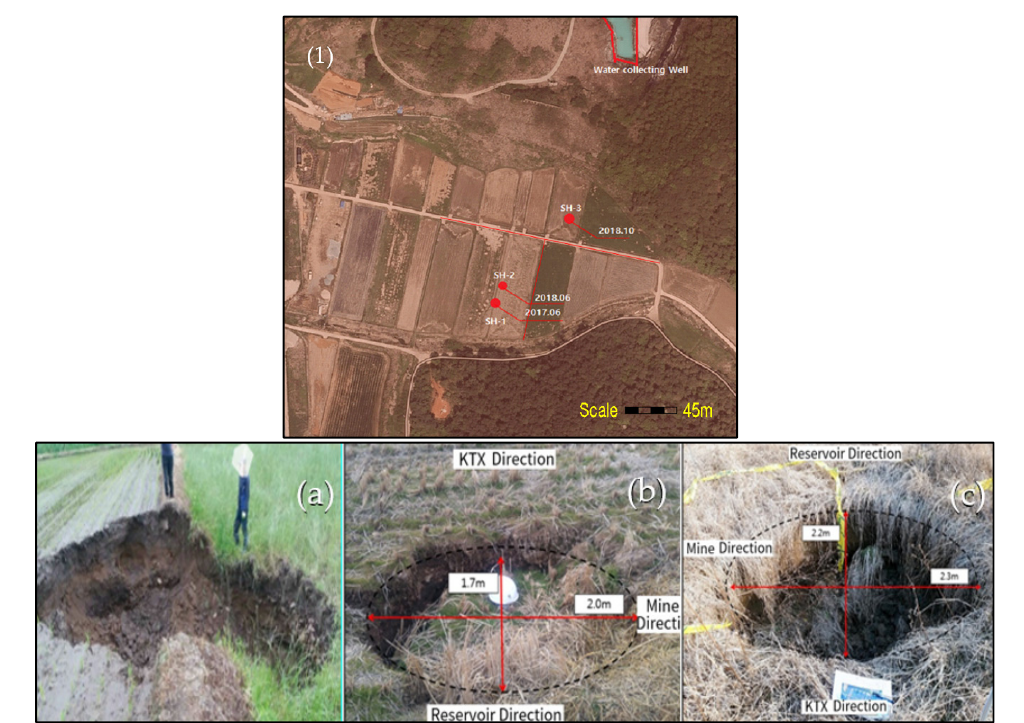
Figure 6. Sinkhole locations and close-up photographs of sinkholes in agricultural land adjacent to Gun-dong mine, (1) Sinkhole locations, ( a ) 2017.06 (Sinkhole-1), ( b ) 2018.06 (Sinkhole-2), ( c ) 2018.10 (Sinkhole-3).